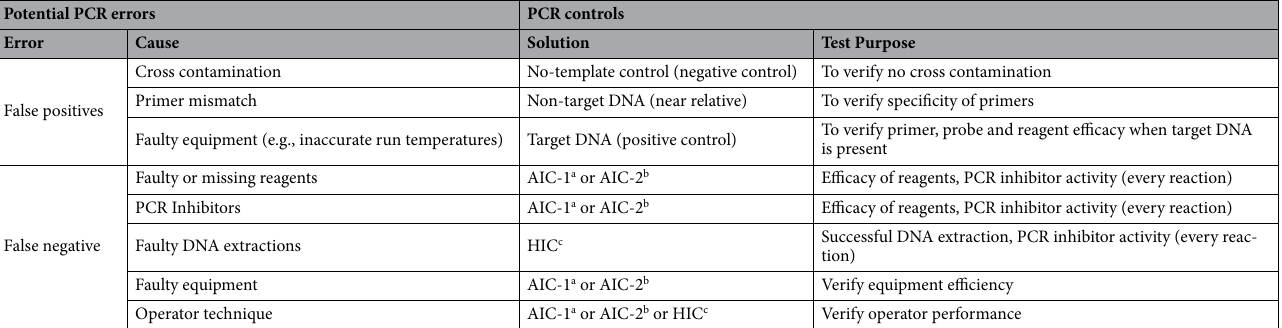
Table 5. Value of internal controls to increase confidence in PCR and qPCR-based diagnostics. a For the AIC-1 control, no additional primer pair is required, the R. toxicus primers will also detect the AIC; b For the AIC-2 control, one additional primer pair and probe (IC-PF2 and IC-PR2 with IC-P1 probe) is required to detect both AIC-2 and host genomic DNA (for host detection, additional probe IC-PLT will be required); c For HIC, one additional primer set and probe (IC-PF2 and IC-PR2 with IC-PLT probe) is